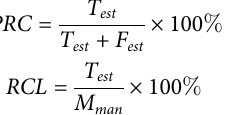
Frontiers in Materials |